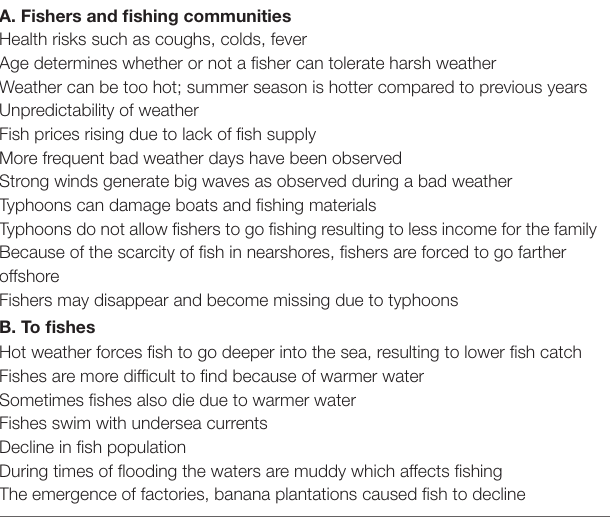
TABLE 7 | Summary of perceived climate change impacts